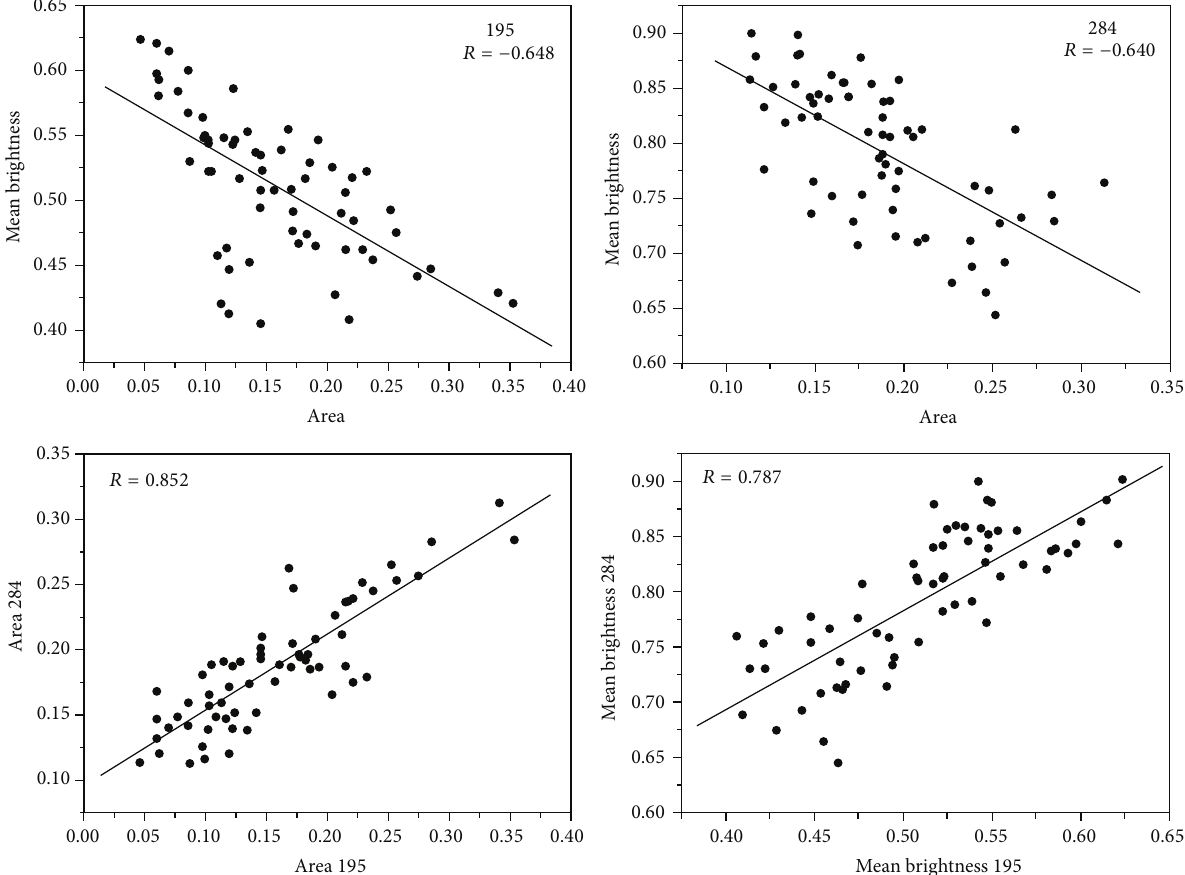
Figure 6: Comparison of CH areas and brightness in two